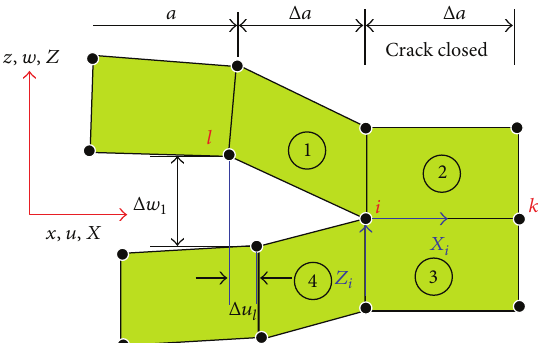
Figure 4: The specimens were tested in the three-point bending configuration, and the load was applied with cylindrical rollers as line load across the top width of the beams. To spread the load and avoid stress concentrations, elastomeric pads were placed between the roller supports and the lower surface of the specimens and between the loading device and the top surface of the specimens. During experimental measurement, the ultimate load which makes crack propagate or makes the reinforced concrete beam fail in fiber, in concrete, or at the interface between them can be achieved according to instrument reading. Virtual crack closure technique (VCCT).